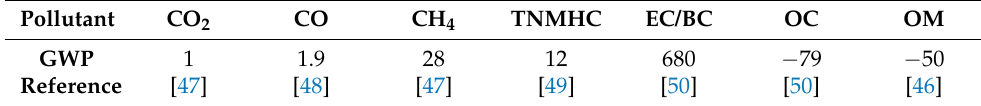
Table 1. Global warming potential values for a 100-year time horizon.